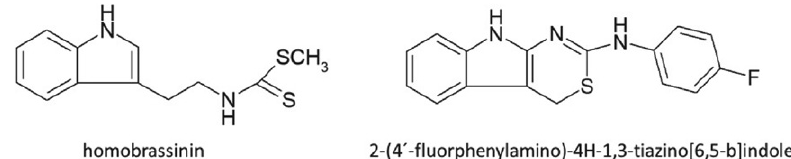
Figure 1. Structure of homobrassinin (K1; N-[2-(indol-3-yl)ethyl]-S-methyldithiocarbamate) and thiazino[6,5-b]indol (K157; 2-(4´- fluorphenyl-